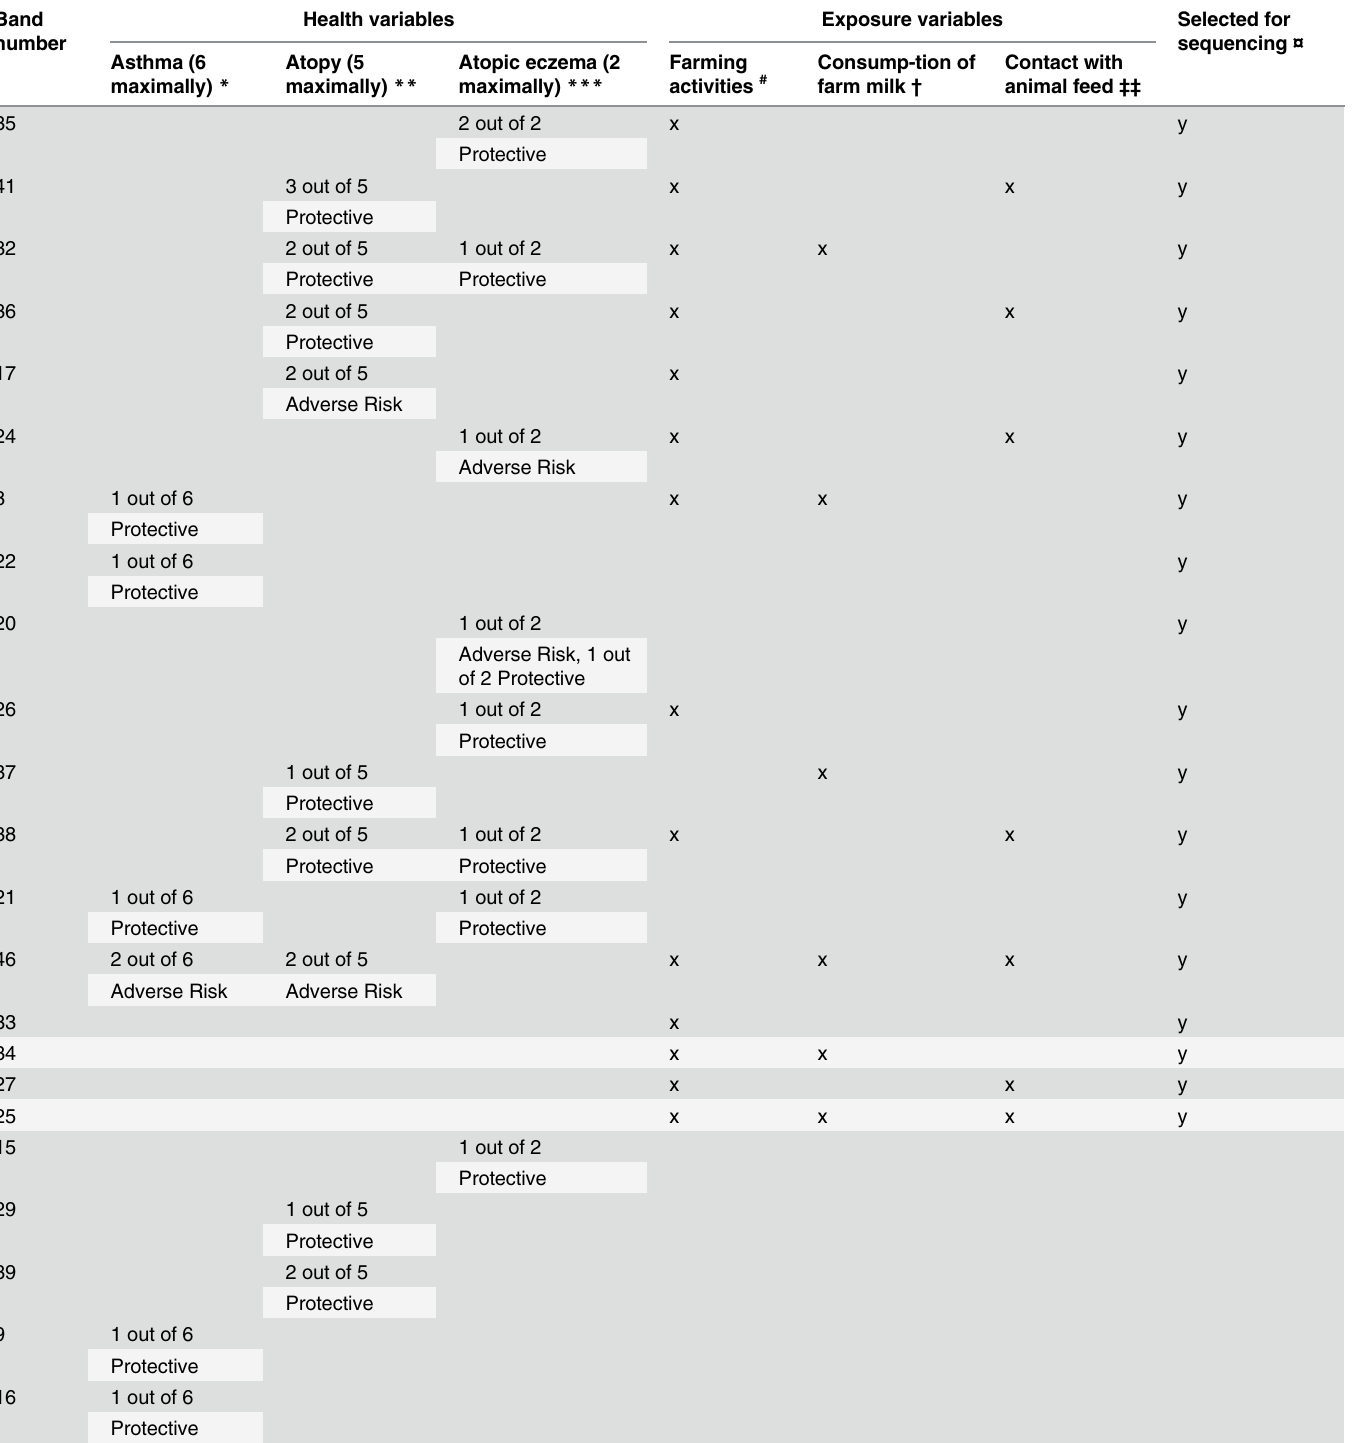
Table 2. Overview of associations between the presence of 43 bacterial taxonomic units (= bands) identified with DNA fingerprinting in mattress dust, and their associations with the health outcomes asthma (6 variables), atopy (5 variables) and eczema (2 variables) and exposure variables (19 variables) (presented are the bands with an association with p < 0.05 in Tobit regression analysis, adjusted for age and